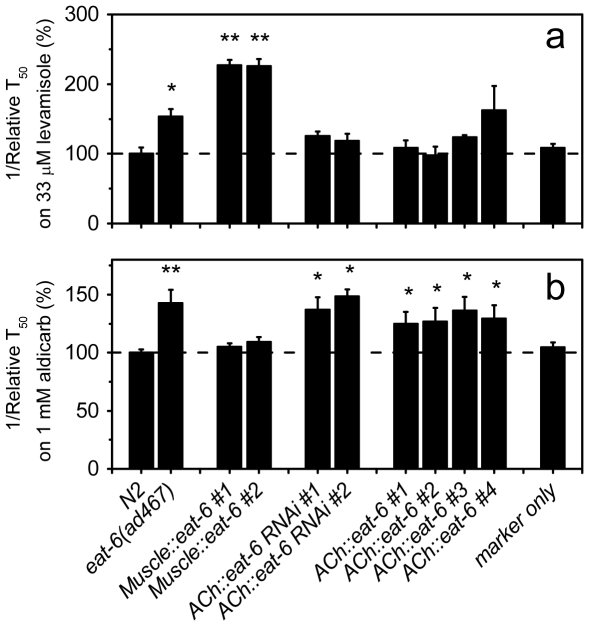

eat-6 in both muscles and neurons regulates synaptic transmission.Synaptic transmission was assayed by scoring paralysis induced by levamisole (a) or aldicarb (b) at concentrations indicated in each panel. The relative reciprocal T50 values were calculated as described in Figure 2a. The error bars indicate SEM (n>3 replicates). * p<0.05, ** p<0.001, compared to WT. Student's t-test.